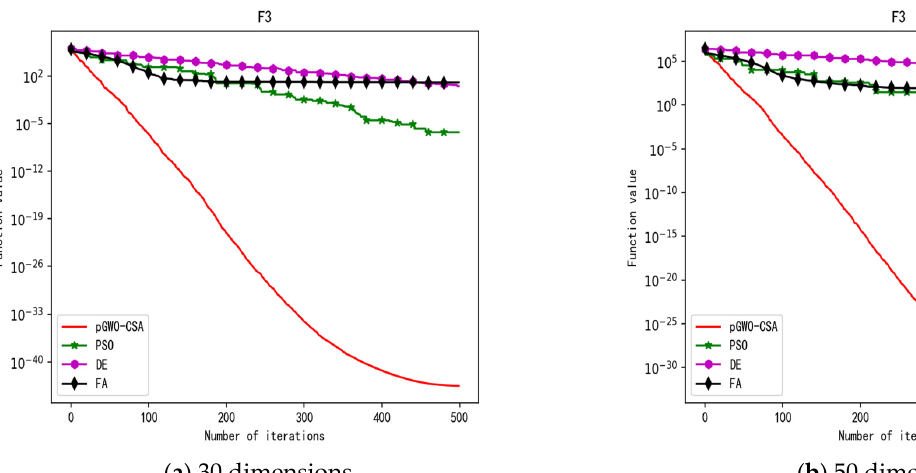
Figure 7. Convergence curve of test function F3.